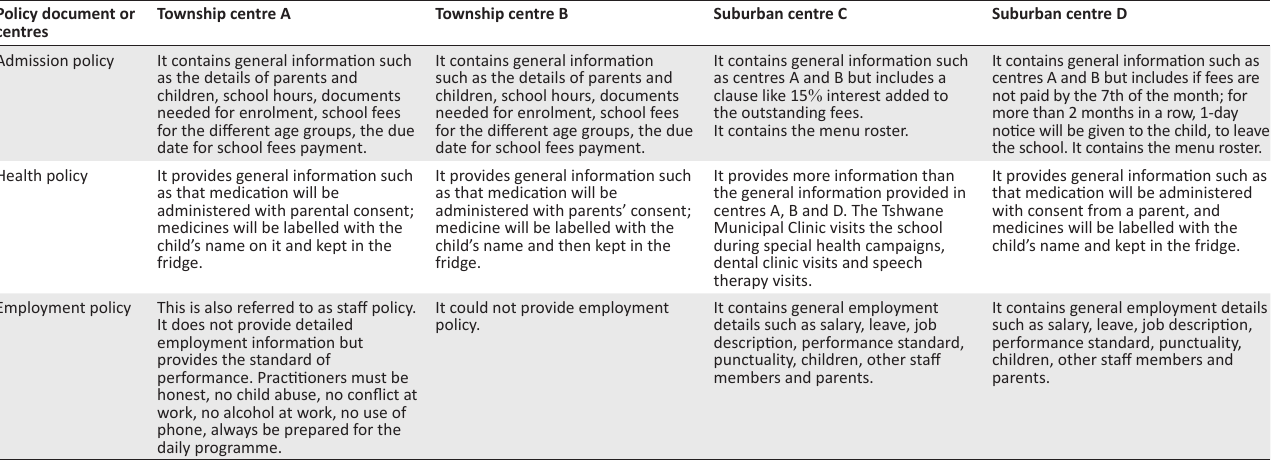
TABLE 2: Document analysis of admission, health and employment policies. Policy document or